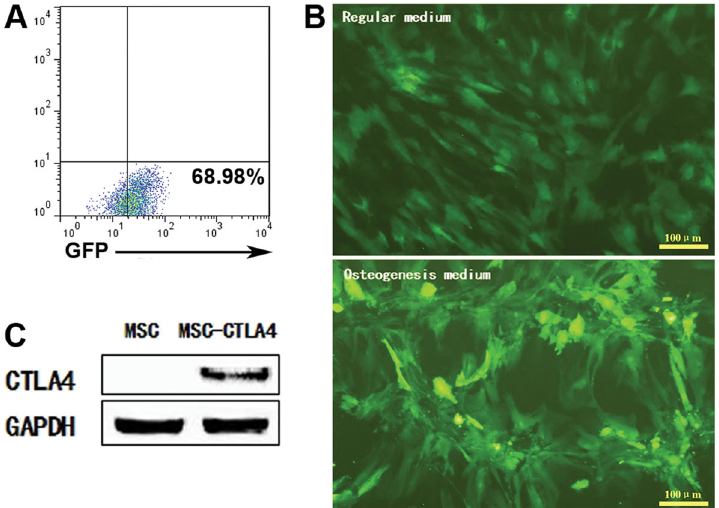
Figure 1. Expression of CTLA4 -Ig in mesenchy- mal stem cells (MSCs)-CTLA4. A , Flow cytometry analysis of green fl uorescent protein (GFP) expression level in MSCs-CTLA4 population shows that the percentage of GFP-positive cells was 68.98%. B , Strong fl uorescent signal in MSCs-CTLA4 as determined by fl uorescence microscopy (magni fi cation 100 (cid:1) ). C , Western blot shows elevated expression of CTLA4-Ig protein in